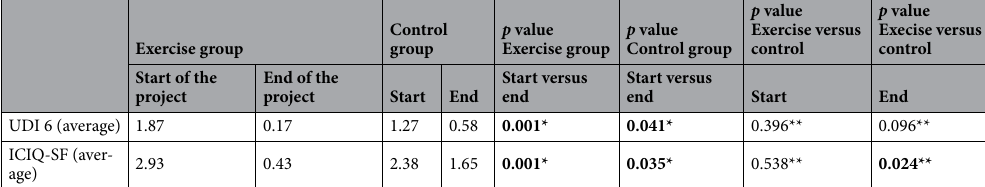
Table 8. Analysis of the UDI 6 and ICIQ-SF questionnaires in both groups. Values statistically significant are in bold. *Wilcoxon test. **Mann–Whitney test.